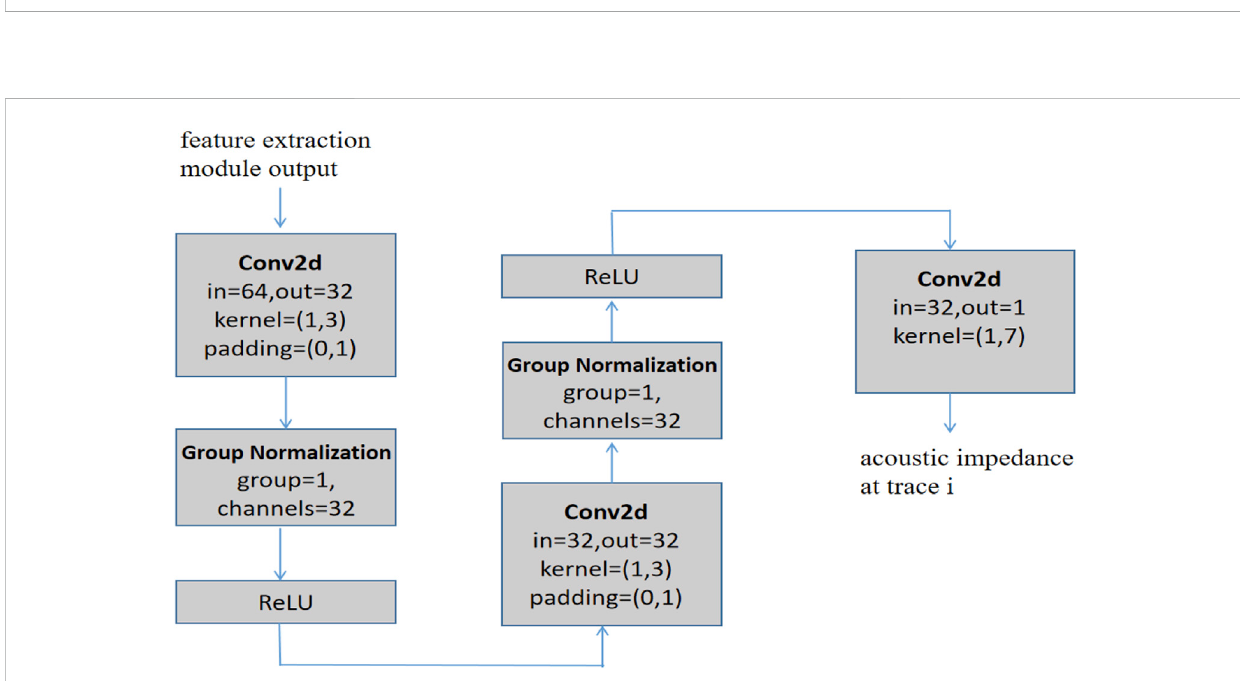
FIGURE 3 Block diagram of the regression